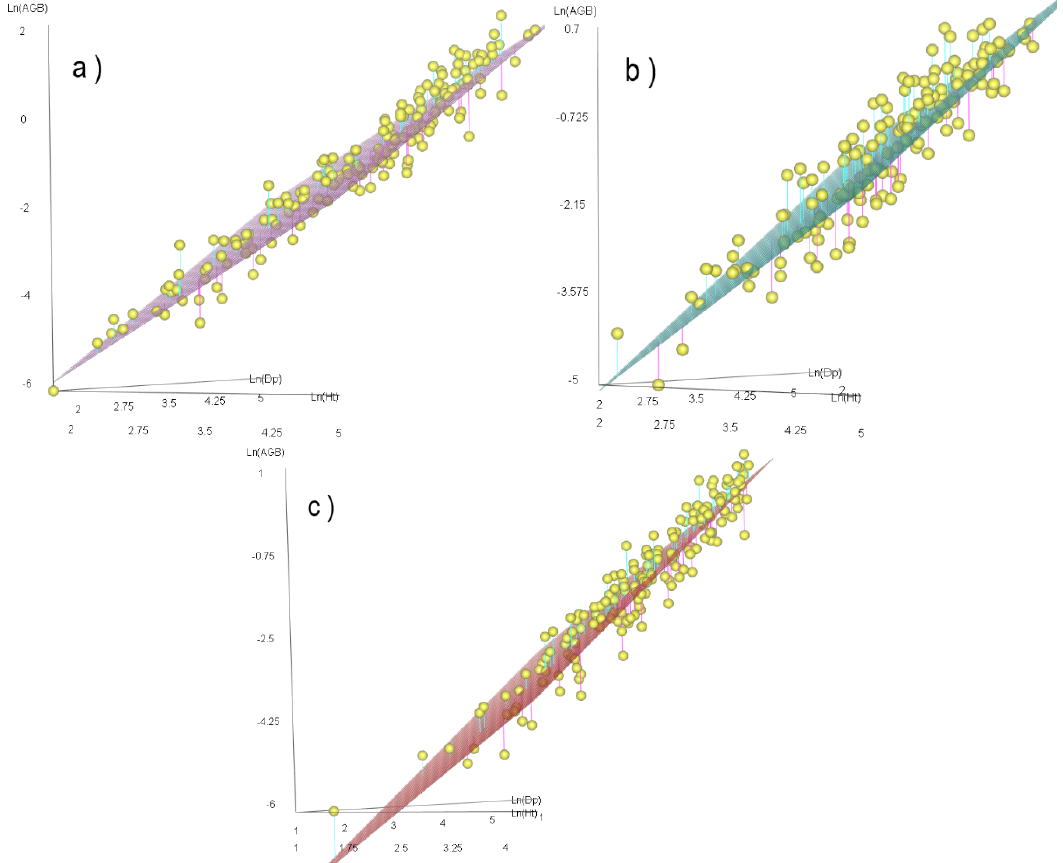
Figure 3. Tridimensional regression plane of Equations (4.d) to (4.f) for estimation of Agave lechuguilla Torr. aboveground biomass in Mexico. ( a ) San Luis Potosí, ( b ) Coahuila, ( c ) Zacatecas. Torr. aboveground biomass in Mexico. ( a ) San Luis Potos í , ( b ) Coahuila, ( c ) Three equations were derived from Equation (4) by effect of the dummy variables. By